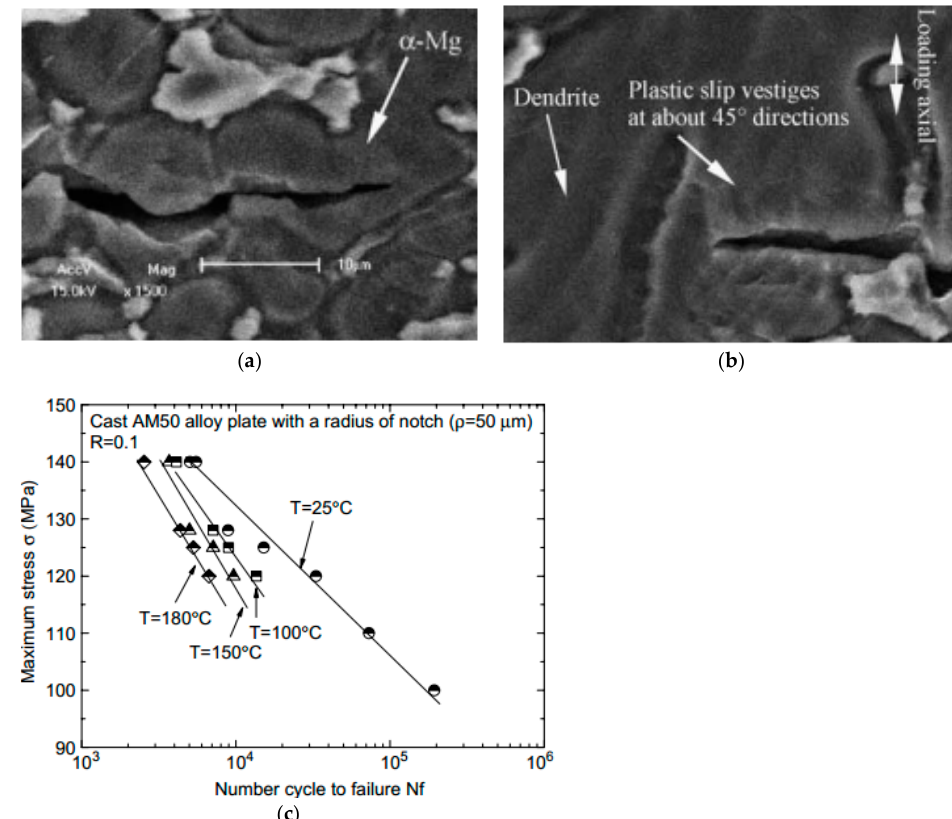
Figure 6. Effects of different temperatures on fatigue characteristics of AM50 magnesium alloy “Reused with permission from Elsevier by License No. 5494620116925” [56]. ( a ) SEM image of fatigue crack tip at σ max = 128 MPa, T = 150 ◦ C 8C, N = 4109; ( b ) SEM image of plastic slip vestiges near crack tip at σ max = 125 MPa, T = 150 ◦ C 8C, N = 5819; ( c ) S–N curves of cast AM50 magnesium alloy in different